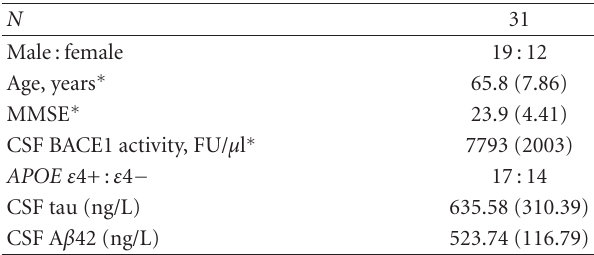
Table 1: Description of the study